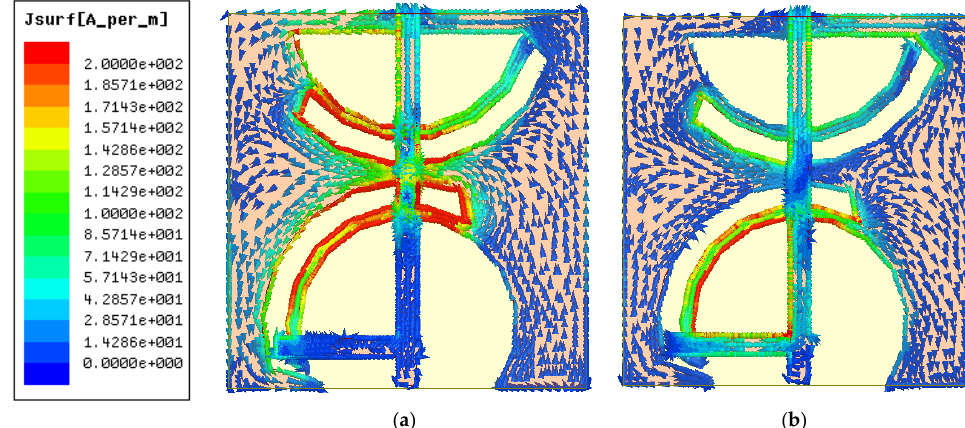
Figure 9. Surface current behavior at: ( a ) 1.8 GHz and ( b ) 2.4 GHz. Measuring the effective lengths corresponding to the current paths represented by the black lines in Figure 10, we find respectively: L 1 = 57 mm which corresponds to a frequency of f 1 = 2.51 GHz and L 2 = 89 mm which corresponds to a frequency of f 2 = 1.61 GHz.